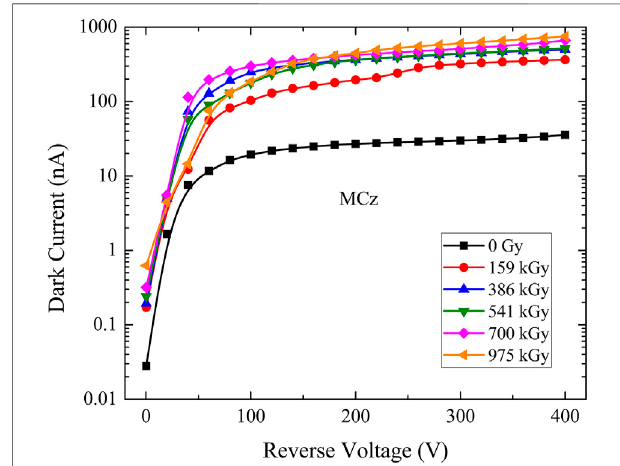
FIGURE 10 | Dark current as a function of the reverse voltage of one pristine MCz diode (0 Gy) and after irradiation up to 975 kGy in incremental steps of almost 150 kGy.